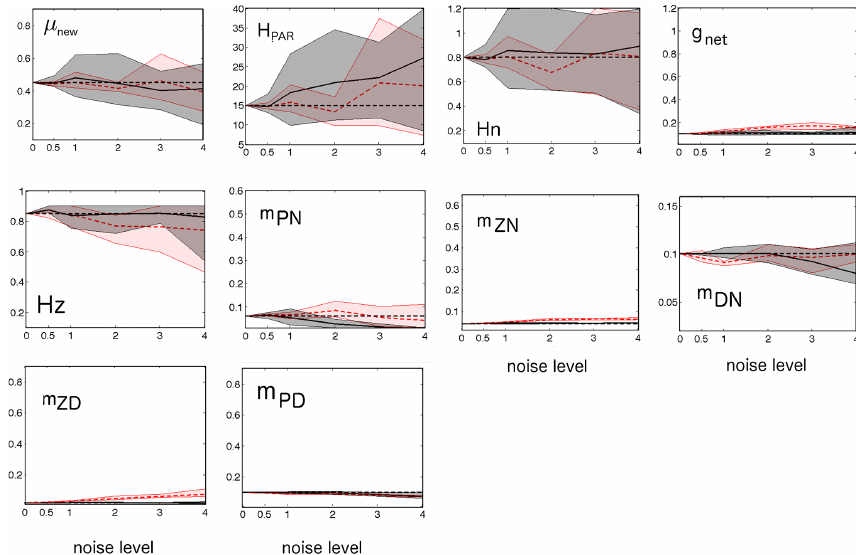
Figure 4. Uncertainties of the estimated parameters as a function of noise added to the synthetic “observations” (underlying the respective parameter optimizations). The magnitude of noise is expressed, as defined in Sect. 2.5. Typical observations correspond to level 3–4 noise (Sect. 2.5). The subplots refer to respective model parameters, indicated by the panel’s legends. The y axis limits match the associated parameter range explored (Table 1). The straight black dashed line refers to the original parameter values (that underlie the genuine truth). The black lines refers to the ensemble mean retrieved by optimization. The grey shaded areas depict the ranges enveloped by all of the five ensemble members that constitute the parameter retrieval experiments at respective noise levels (NOISE). In all cases shown here the external forcing is OPTI. The red lines and red shaded areas are similar to the solid black line and grey shaded area, except that they refer to MISSING-ZD (as described in Sect. 2.5).